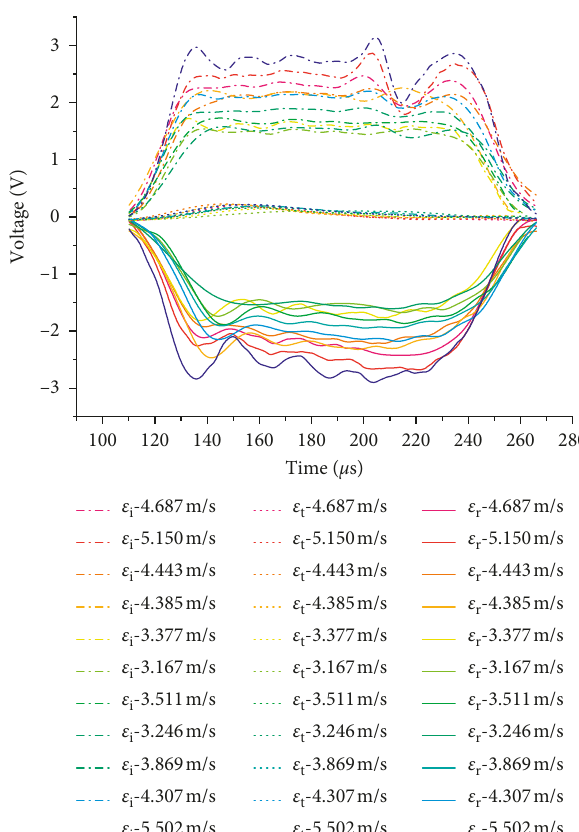
Figure 14: Incident, reflected, and transmitted signals of rocks under different impact velocities.